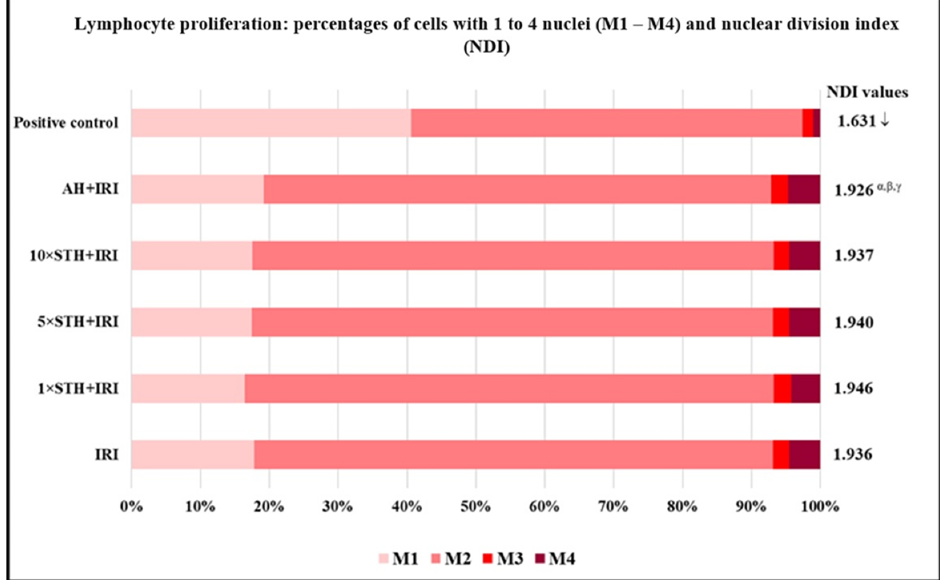
Figure 4. Parameters of cell proliferation established after treatment with different combinations of cytotoxic drug irinotecan (IRI) with strawberry tree honey (STH) and artificial honey (AH). Single-IRI-treated cells and positive control (bleomycin—15 mg/L) cells were studied in parallel. Significantly decreased ( p < 0.05) values are ↓ —vs. all other experimental groups; I—vs. IRI; α —vs. 1 × STH + IRI sample; β —vs. 5 × STH + IRI sample; γ —vs. 10 × STH + IRI sample.